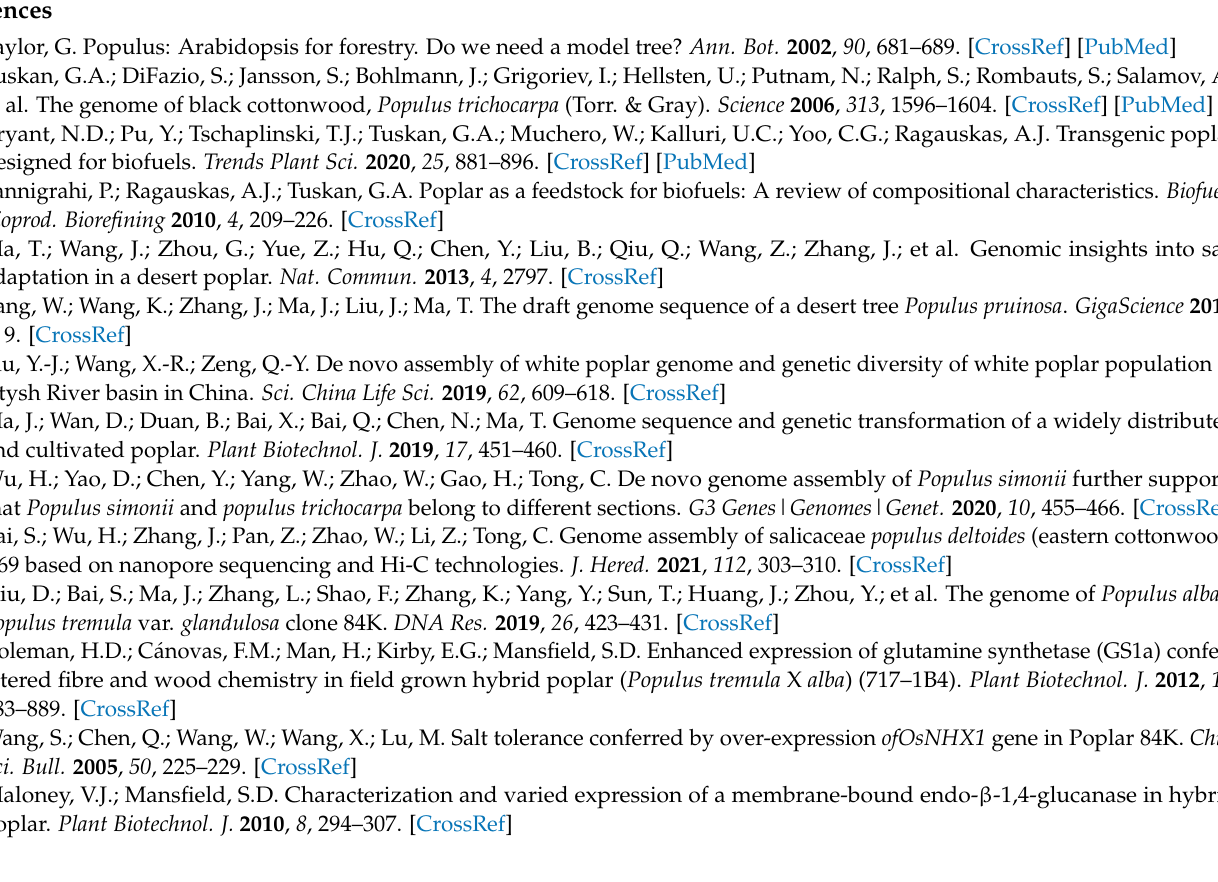
Table S1: Plasmids used and constructed in this study; Table S2: Primers used in this study. Refer- ences [33,34,66] are cited in the Supplementary